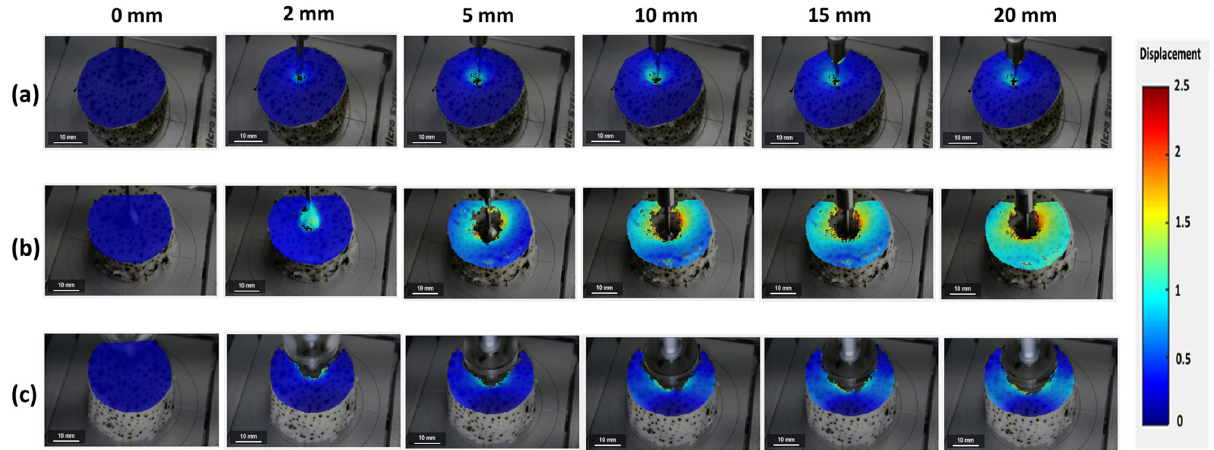
Figure 3. Contour plot of surimi gel displacement during a penetration test using ( a ) a cylindrical probe, ( b ) a spherical probe, and ( c ) a conical probe.